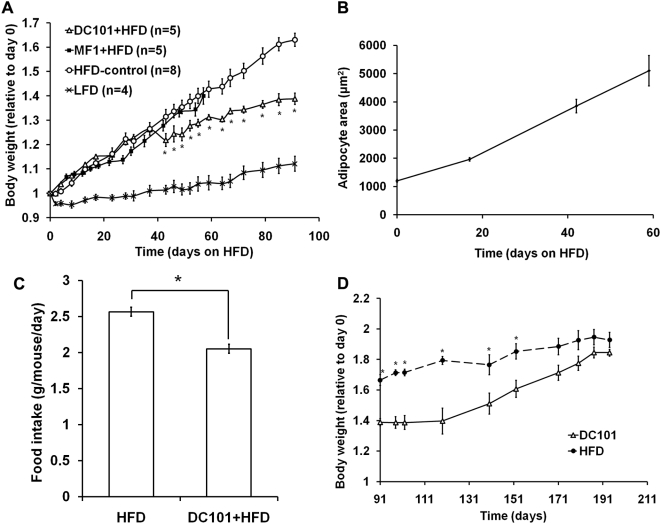
Effects of VEGFR1 and VEGFR2 blockade in mice with DIO.
A: Body weight gain relative to weight at day 0 for mice given different diets and treatments. Male C57BL6 mice, 10–12 weeks old at time 0, were used for all groups. All diets and treatments began at day 0, at dosages and schedules as described in the Methods section. DC101+HFD: high fat diet, DC101 treatment, white triangles. MF1+HFD: high fat diet, MF1 treatment, black squares. HFD: high fat diet controls, no treatment (n = 4) or PBS treatment (n = 4), white circles. LFD: standard diet controls, crosses. B: Average cross-sectional area (µm2) of adipocytes in the perigonadal fat pad at various times after beginning of high fat diet. 3–4 mice at each time point, >300 adipocytes measured for each mouse. Adipocytes in the inguinal fat pad showed a similar trend (not shown). C: Food intake (g/day/kg body weight) in the DC101+HFD versus HFD groups, when the DC101+HFD group was gaining less weight (days 43–91). D: Reversibility of the effects of DC101. DC101 treatment was discontinued from day 91 onward. About two weeks after cessation of treatment, the rate of weight gain in the previously treated animals resumed at a higher rate, and their body weights eventually caught up with untreated controls. All data reported as mean±sem. Asterisks denote significant difference between DC101+HFD and HFD groups (P<0.05).